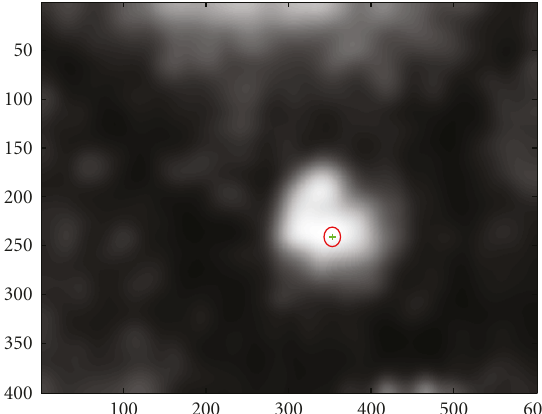
Figure 5: Maximum detected: green cross and the initial snake in red. The image is presented at initial scale ( s = 0) after up sampling operation on Blue/Yellow conspicuity